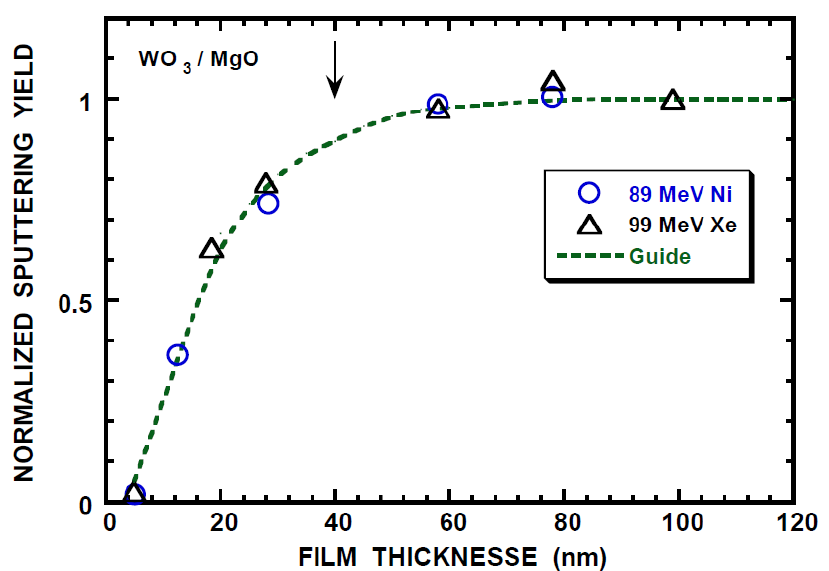
Figure 7. Sputtering yields of WO 3 by 89 MeV Ni (o) and 99 MeV Xe (∆) ions with the equilibri- um-charge incidence vs. film thickness. The experimental yields after [69] are normalized to that at saturation (4.7 × 10 3 and 24 × 10 3 for 89 MeV Ni and 99 MeV Xe ions). The vertical line with arrow indicates the effective depth (40 nm) for the electronic sputtering and dashed line is a guide for eyes.